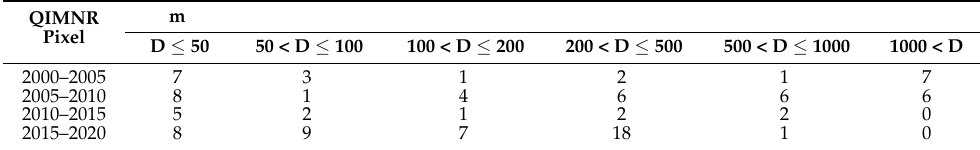
Table A3. The quantity relationship of lost mangrove pixels and the distances between mangroves and driving factors in QIMNR.